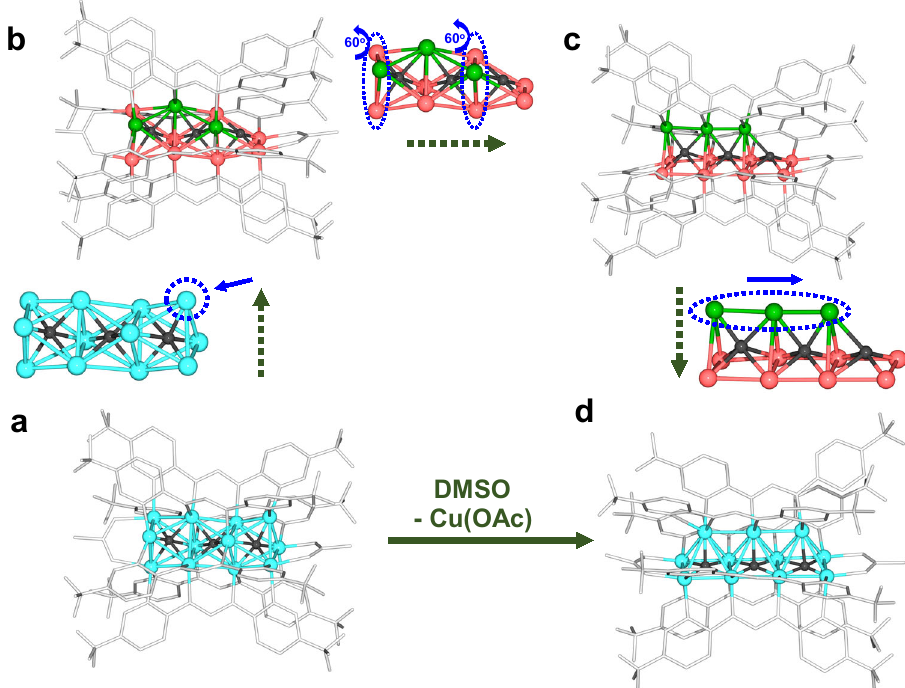
Fig. 6 Hypothetic step-by-step transformation from Cu 12 to Cu 11 . a , b DMSO takes away an unsaturated copper atom; b , c two Cu 3 units of Cu 12 twist for 60° along with the binding mode of Tf-dpf changes; c , d the translation of linear Cu 3 unit. Color legend: light blue, red, and green Cu; gray, Tf-dpf; black,